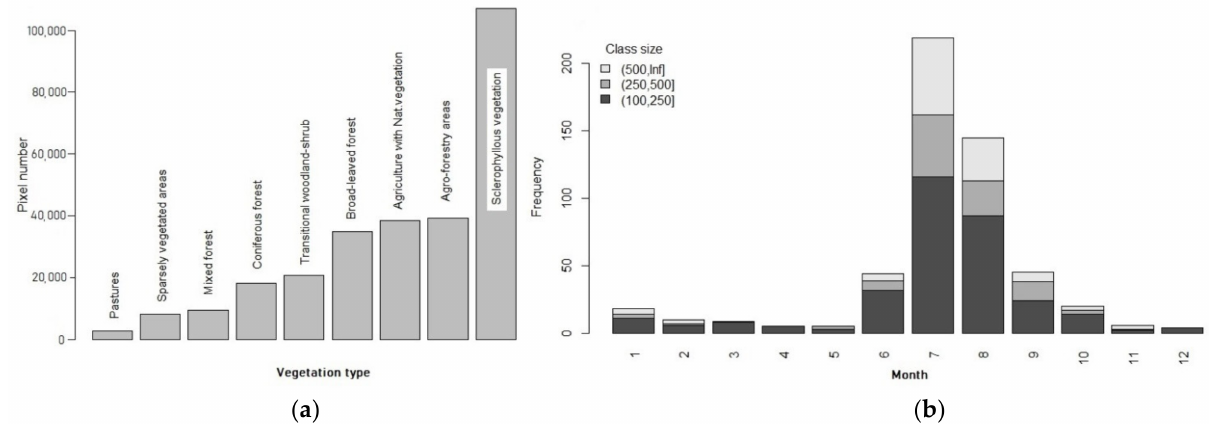
Figure 2. Number of pixels (30-m resolution) under analysis within the studied area (period 2004–2017) across CLC vegetation types ( a ) and fire frequency ( b ) across different months and fire size classes (in